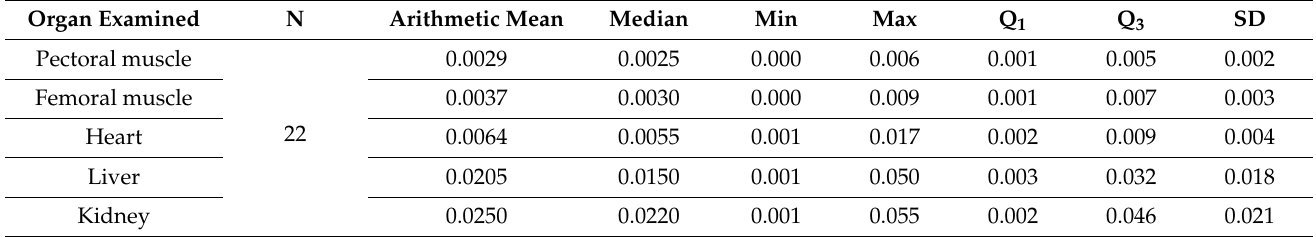
Table 2. Mercury concentrations in organs of Eurasian magpies in milligrams per kilogram of wet